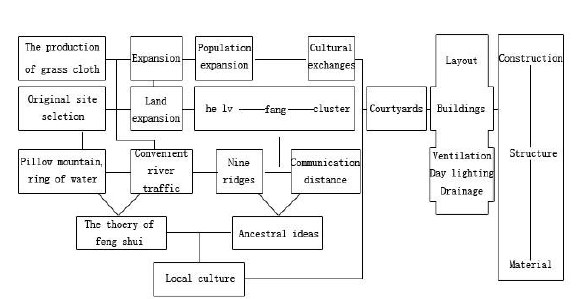
Figure 10. The chart of construction logic in